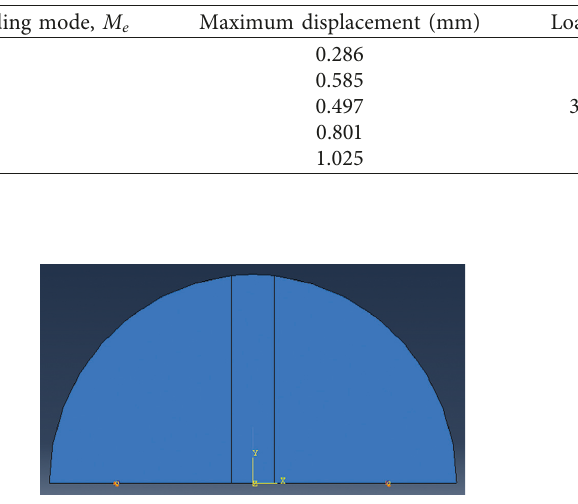
Figure 5: Geometric model and boundary conditions. Figure 6: Mesh of XFEM.